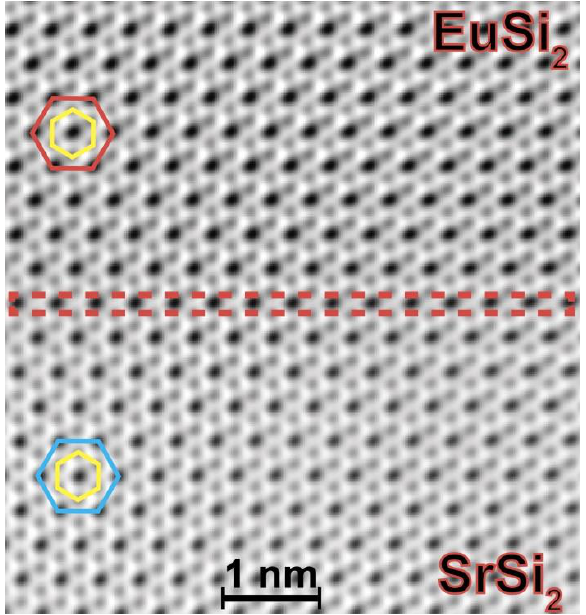
Fig. 4. Cross-sectional BF-STEM image of the SiO x /EuSi 2 /SrSi 2 /Si(001) film. It shows the boundary between EuSi 2 and SrSi 2 phases as well as hexagons of Eu (red), Sr (blue) and Si (yellow).